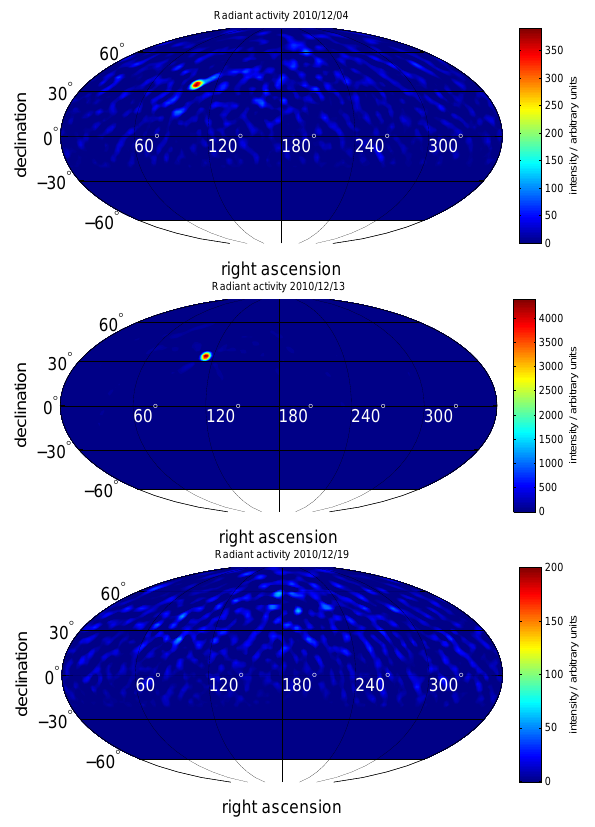
Fig. 2. Radiant activity maps during all three ECOMA sounding rocket flights measured with the Andenes meteor radar.